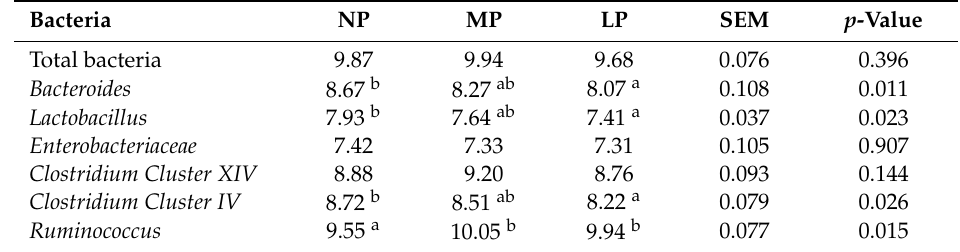
Table 7. Quantitative analysis of bacterial populations in the colonic digesta of pigs, Lg(copies / g wet content). Bacteria NP